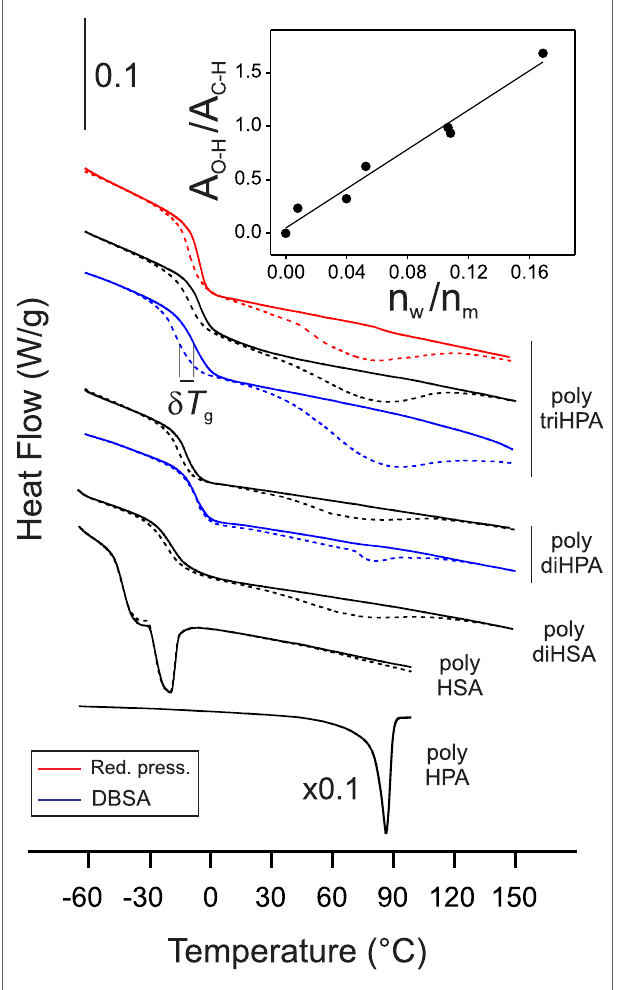
FigUre 5 | Dsc thermograms of polyesters under n 2 flow . Dashed lines correspond to samples stabilized at 55% RH and display the desorption of water around 80°C. Solid lines correspond to in situ dried samples. The inset in the upper right corner shows the correlation between the FTIR ν (O–H)/ ν (C–H) band area ratio and the amount of adsorbed water ( n w ) calculated from DSC and referred to the monomer content ( n m )